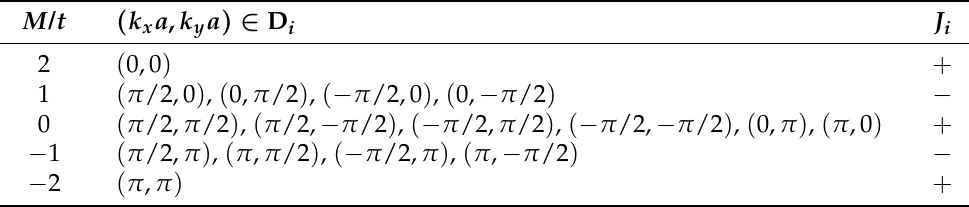
Table 2. The sign of d z = M the Chern number C = 1